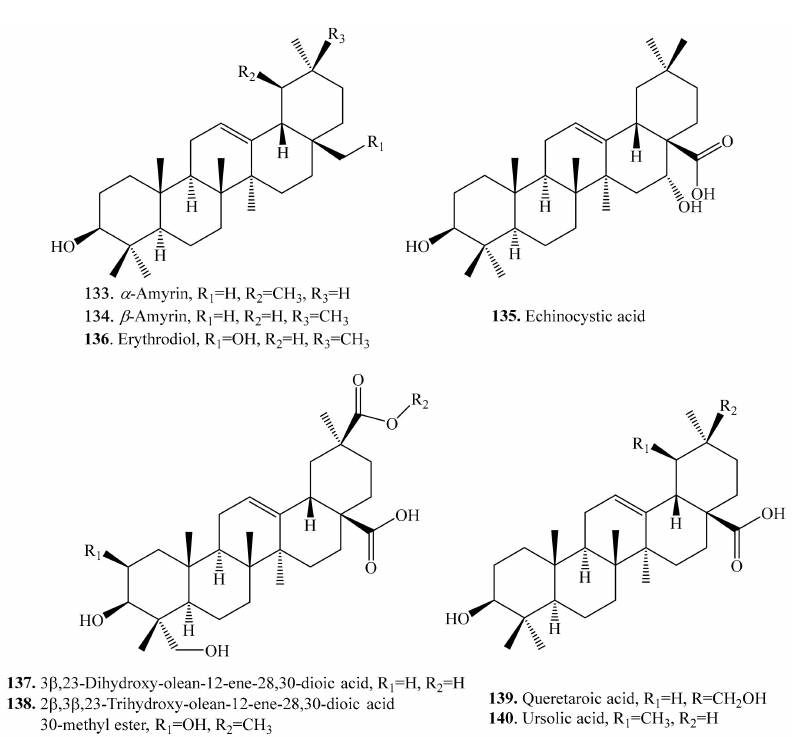
Figure 20. Structures of the other pentacyclic triterpenoids isolated from quinoa.